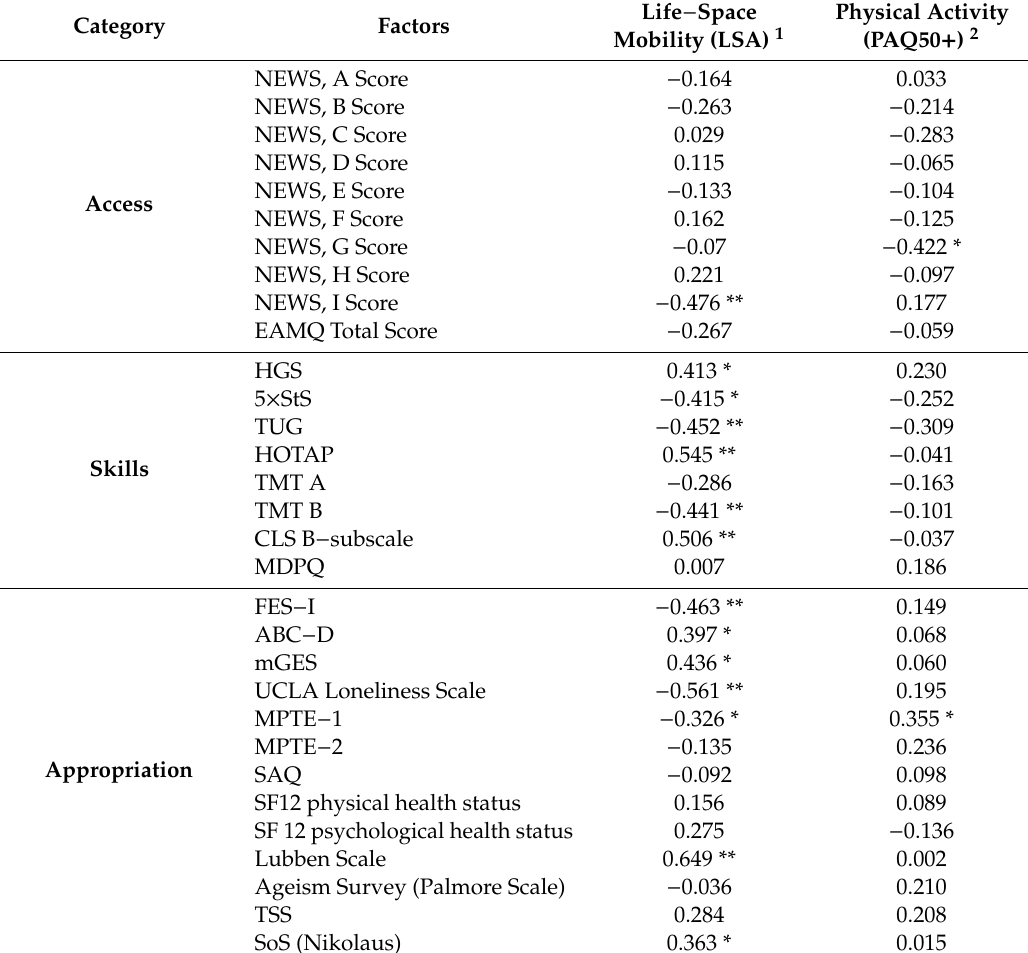
Table 4. Relationship of the factors of motility with life-space mobility and physical activity (Spearman’s / Pearson’s coe ffi cient of correlation, r (* p < 0.05; ** p < 0.01)). Category